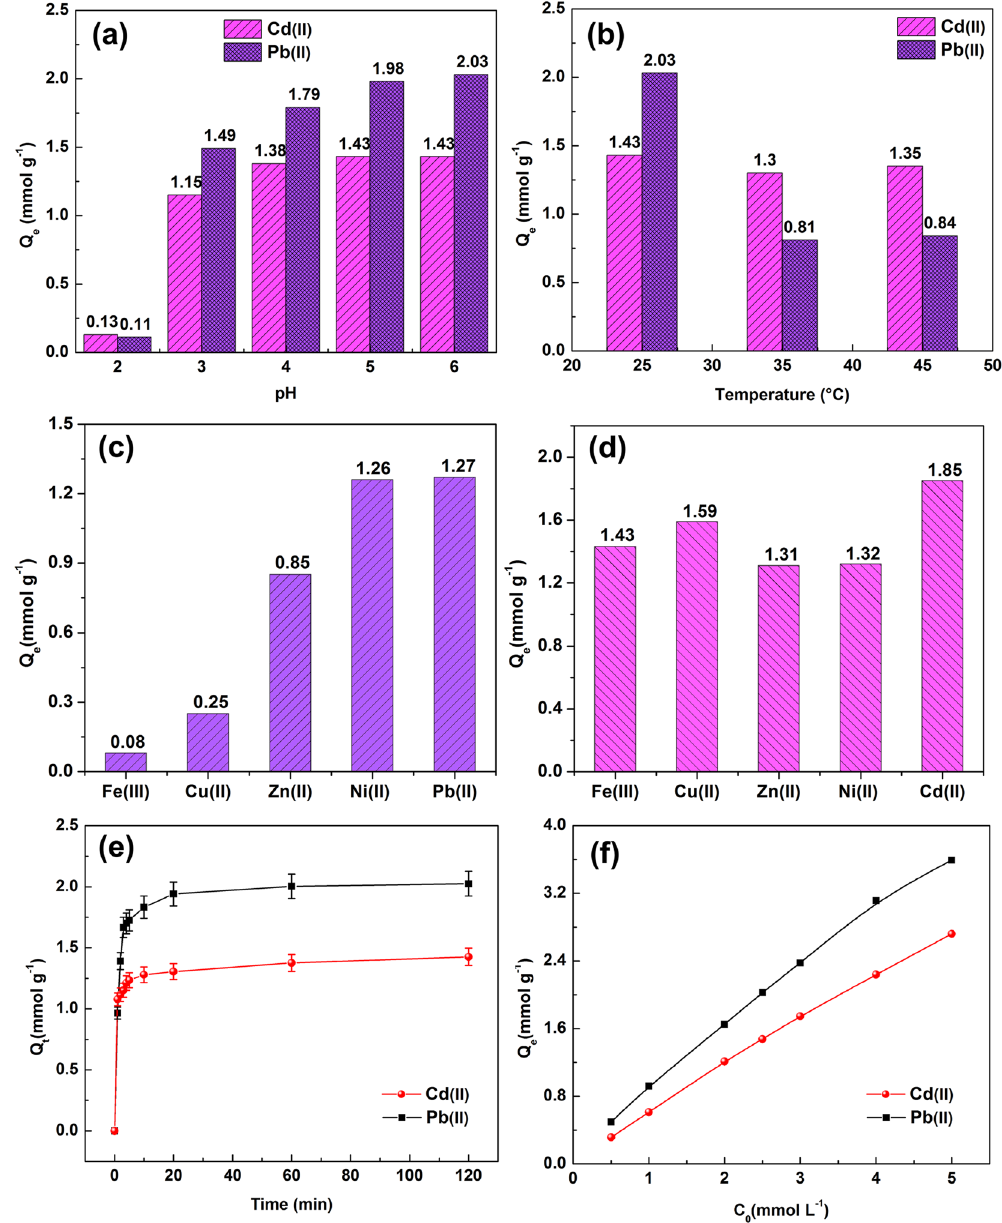
Figure 5. Effect of ( a ) pH value and ( b ) temperature on Cd(II) and Pb(II) ions adsorption; effect of competitive ions on ( c ) Cd(II) and ( d ) Pb(II) adsorption; ( e ) adsorption time and ( f ) initial concentration on Cd(II) and Pb(II) ions